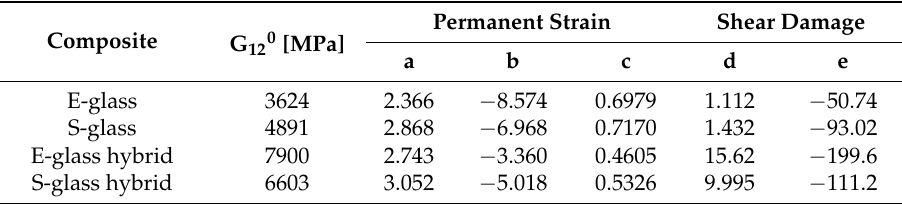
Table 2. Average curve fitted parameters for each composite type. Table 3. Average curve fitted parameters for each composite type.